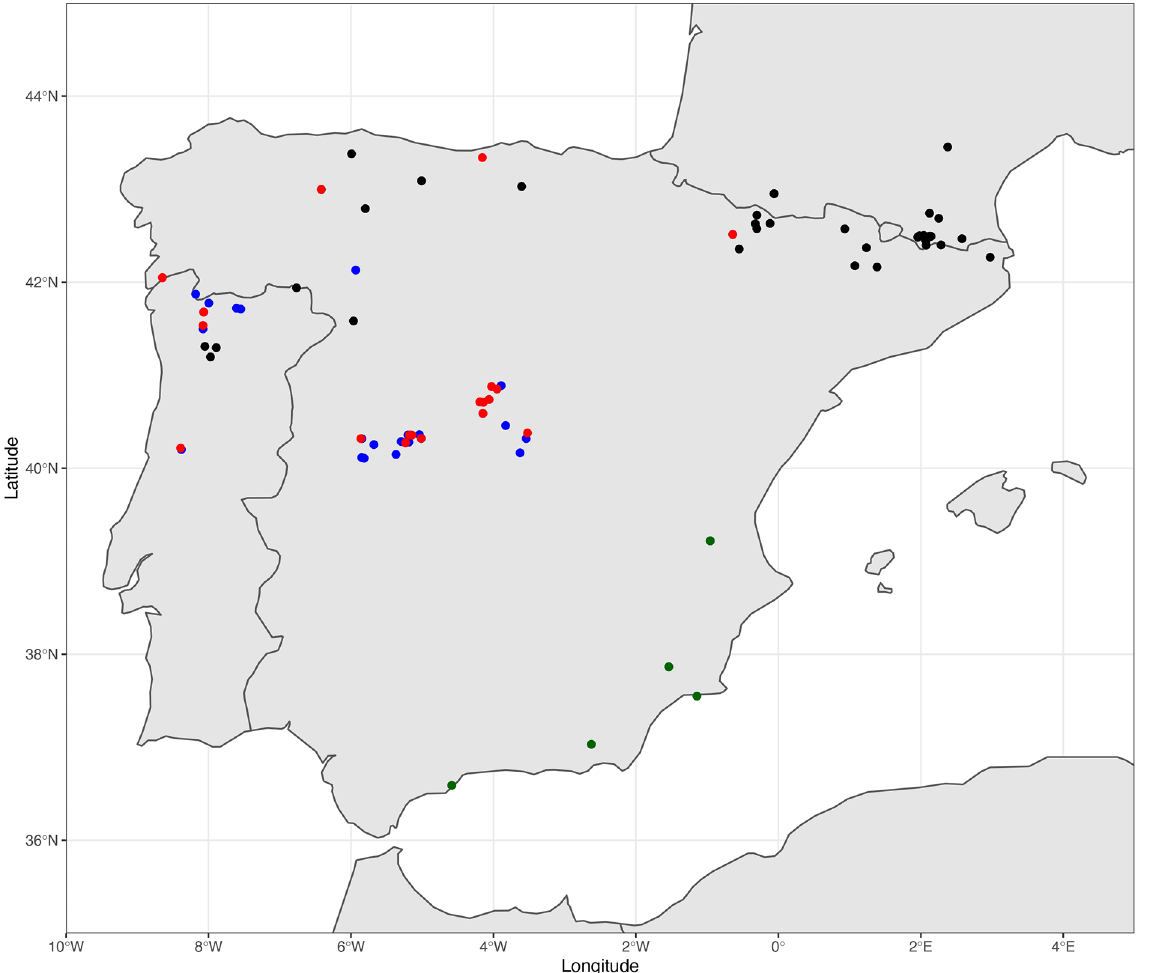
Fig. 3. Distribution of Andrena ( Taeniandrena ) benoisti Wood & Praz sp. nov. [blue dots], A. ( T. ) wilkella (Kirby, 1802) [black dots], A. ( T. ) gredana Warncke, 1975 stat. nov. [red dots], and A. ( T .) levante Wood & Praz sp. nov. [green dots] in Iberia. Not to